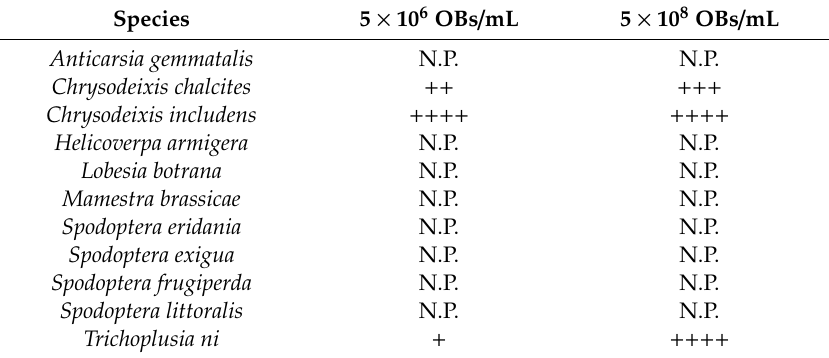
Table 1. Host range for ChinNPV in second instars of di ff erent lepidopteran species.